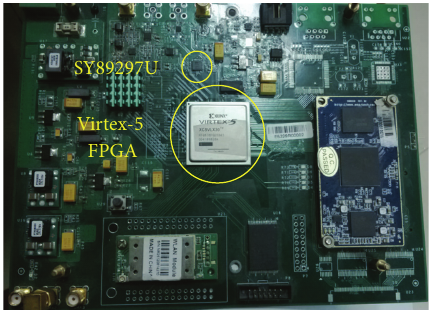
Figure 3: Photograph of the radar board.